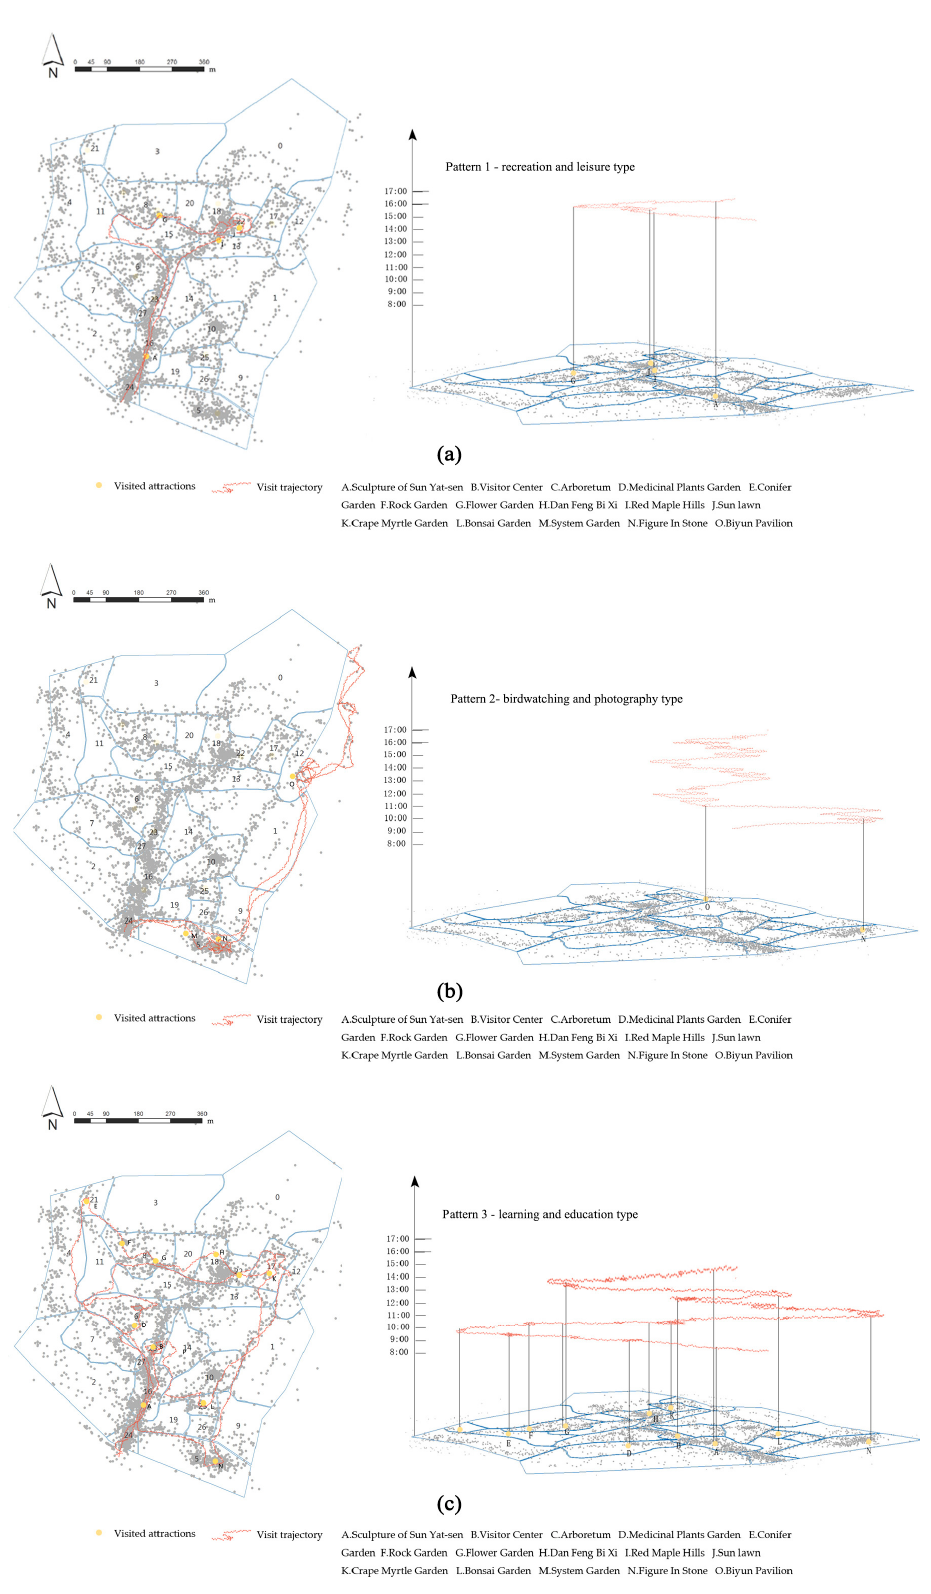
Figure 5. Three types of tourist spatial–temporal behavior patterns (typical sample): ( a ) pattern 1 (recreation and leisure); ( b ) pattern 2 (birdwatching and photography); ( c ) pattern 3 (learning and education).